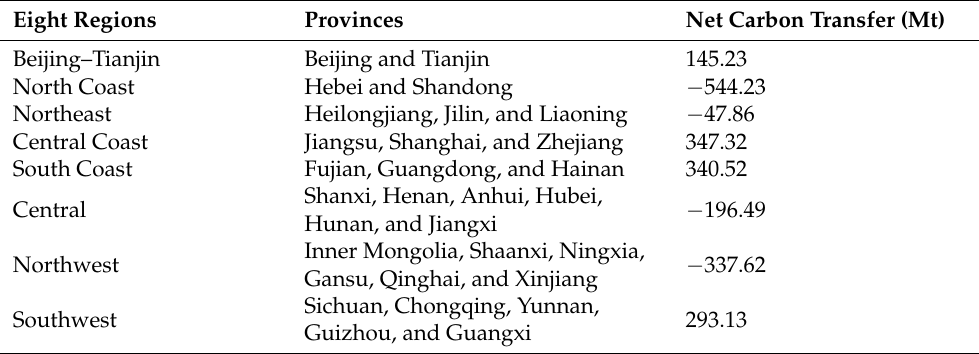
Table 2. Classification and net carbon transfer for each major region.